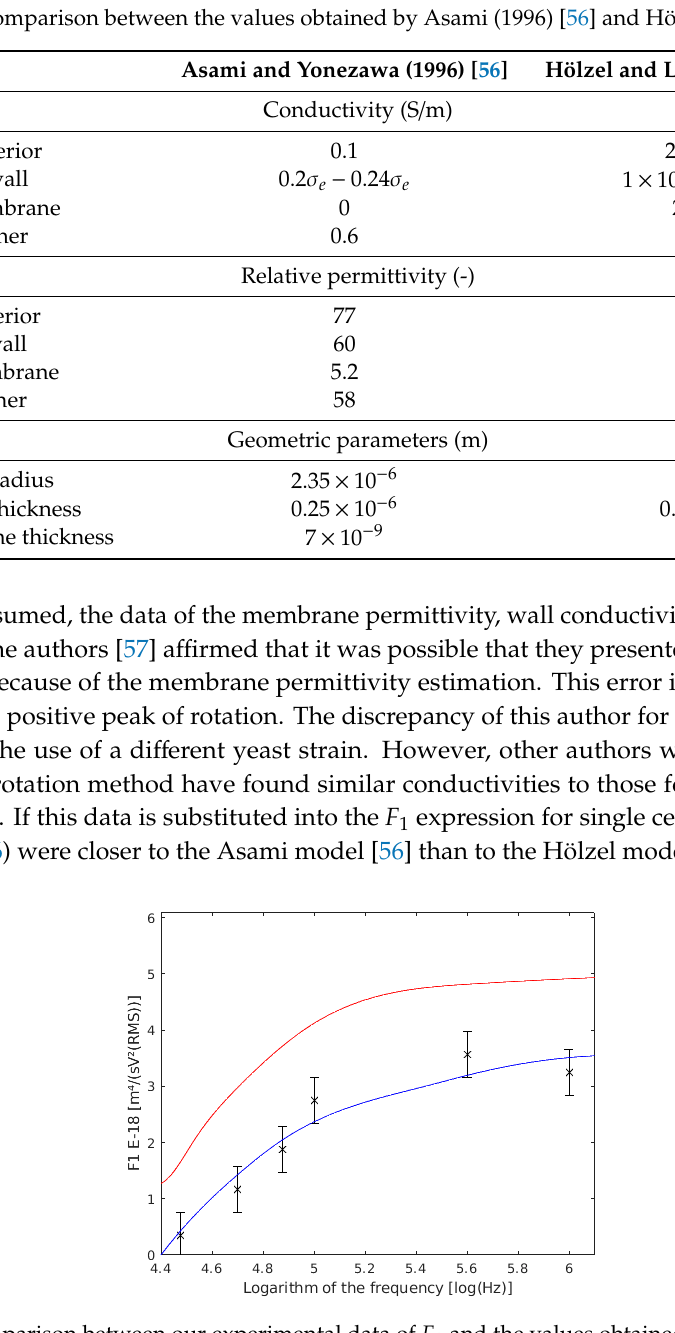
Figure 6. Comparison between our experimental data of F 1 and the values obtained by other authors, both of single cells. F 1 with the data of Holzel are shown in red, the data of Asami are shown in blue, and the results of this work are the six points with their confidence intervals drawn.